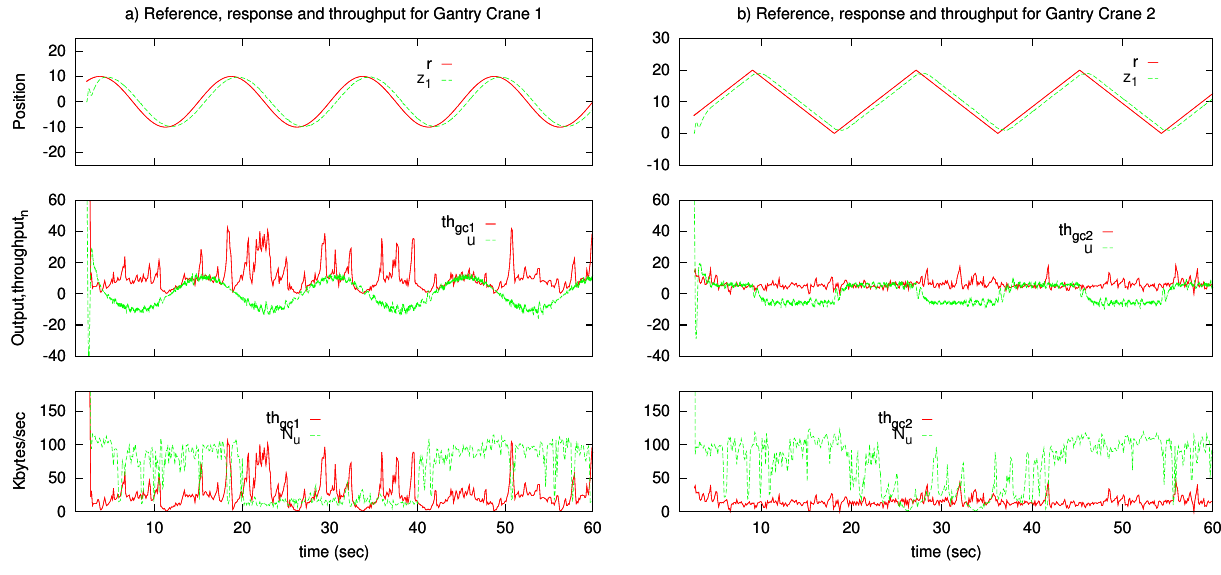
Figure 12. Simulation results for Network Adaptive Deadband.